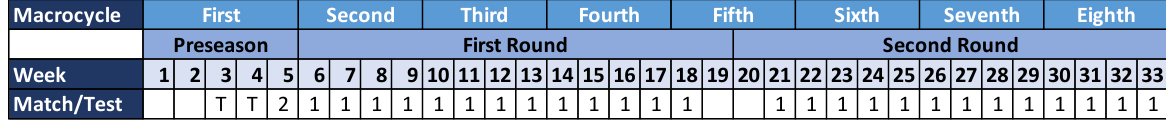
Figure 1. Data collection phases.